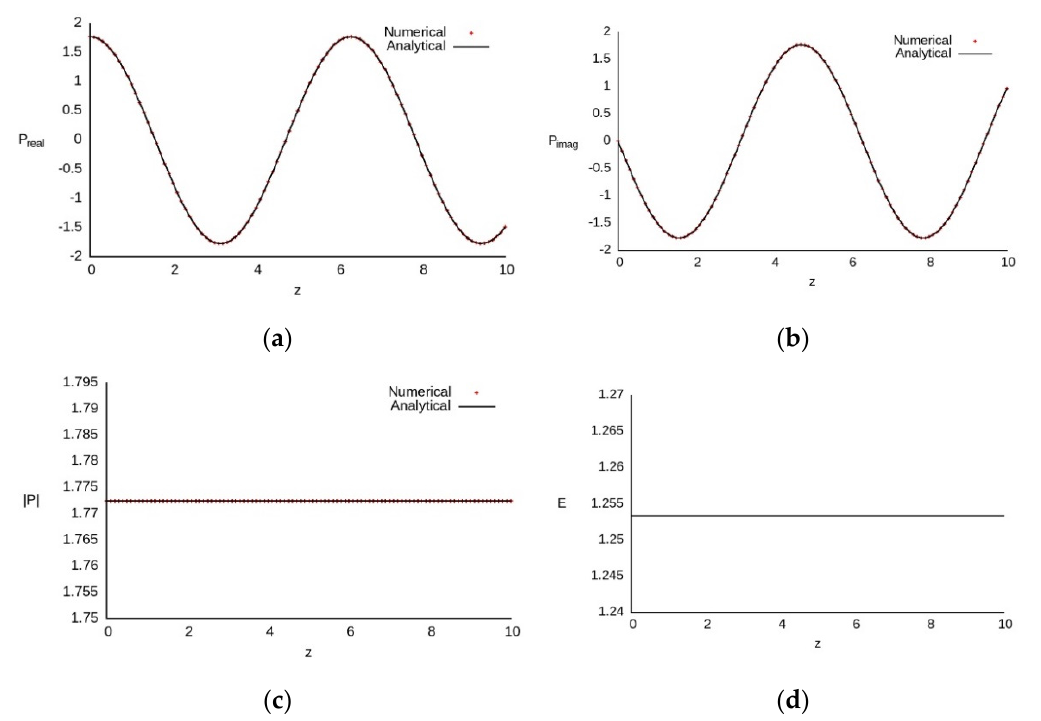
Figure 1. The function P ( z , L t ) (4c) evolution: real part ( a ), imaginary part ( b ), its modulus ( c ), and the pulse’s energy ( d ) obtained via computer simulation (red dotted line) and analytical solution (black solid line) with the parameters D 2 ω = 0, δ 0 = 0, n 0 = 1.